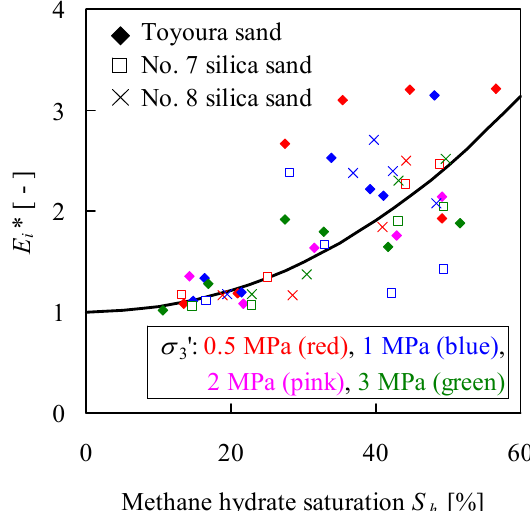
Figure 9. Normalized initial tangent elastic modulus E for hydrate-sand specimens. The curve is calculated using Equation S h